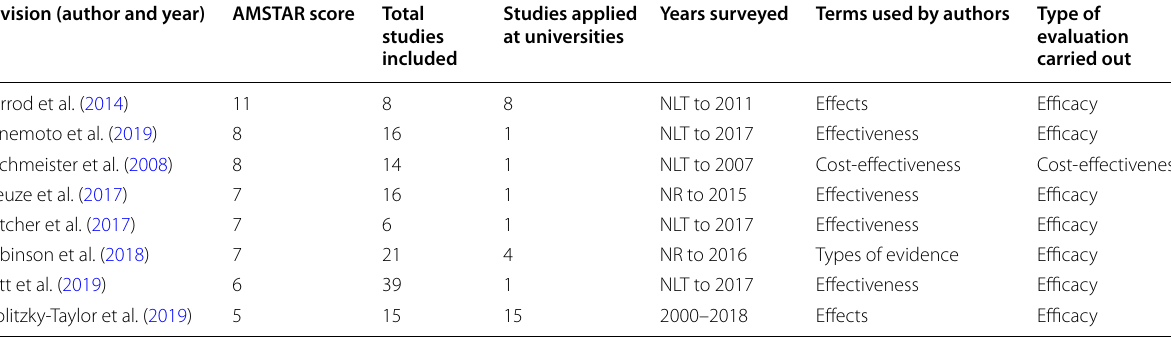
AMSTAR A tool to assess systematic literature reviews, NTL no time limit, NR not reported